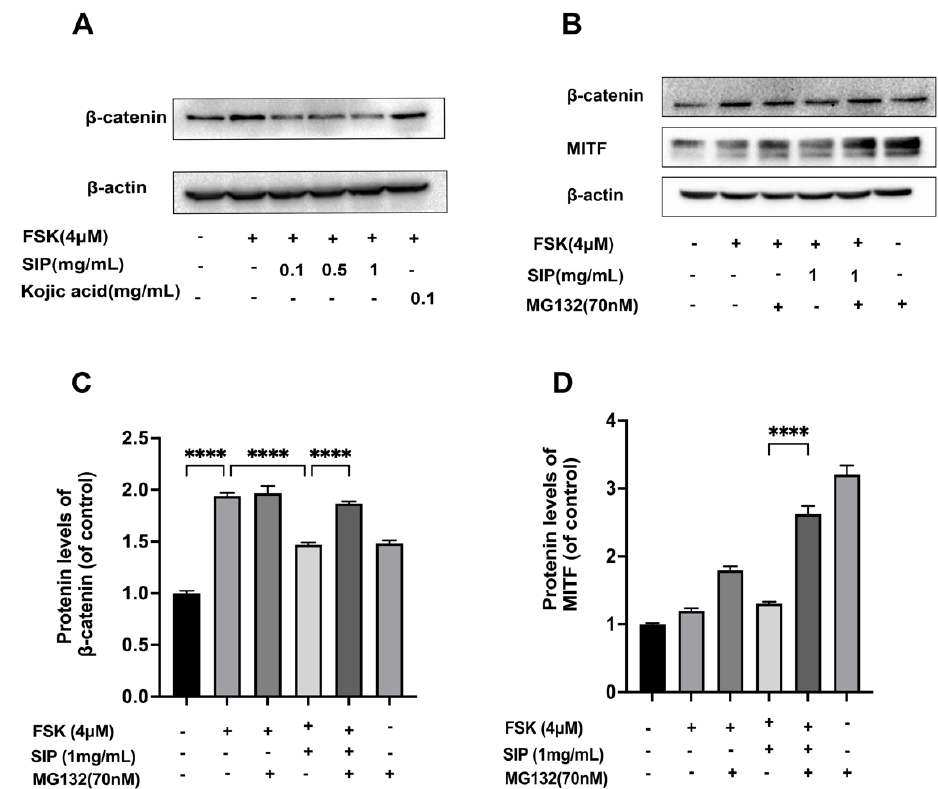
Figure 8. Effects of SIP on the β -catenin signaling pathway in FSK-stimulated B16F10 melanoma cells. ( A ) Protein expression levels of β -catenin were detected by Western blot following SIP treatment for 72 h with the indicated concentration. ( B ) Protein expression levels of β -catenin and MITF were detected by Western blot following preincubation with 70 nM MG132 for 4 h before adding 1 mg/mL SIP and then incubated for another two days. The densitometric analysis of β -catenin ( C ) and MITF ( D ) after MG132 treatment using Photoshop software. Results were presented as mean ± SD. Statistical analysis was performed with one-way ANOVA, followed by Tukey’s multiple comparison test ( n = 3; **** p < 0.0001 compared with the forskolin-stimulated group).